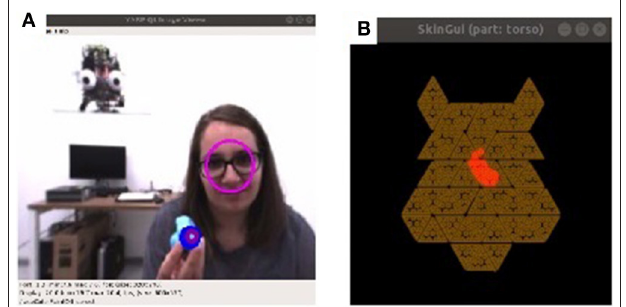
FIGURE 1 | The two outputs from the perception module. (A) Shows an example of face detection and toy tracking. (B) Shows in red the area of the iCub’s torso touched by the participant. (Informed consent of participants has been obtained for the use of their